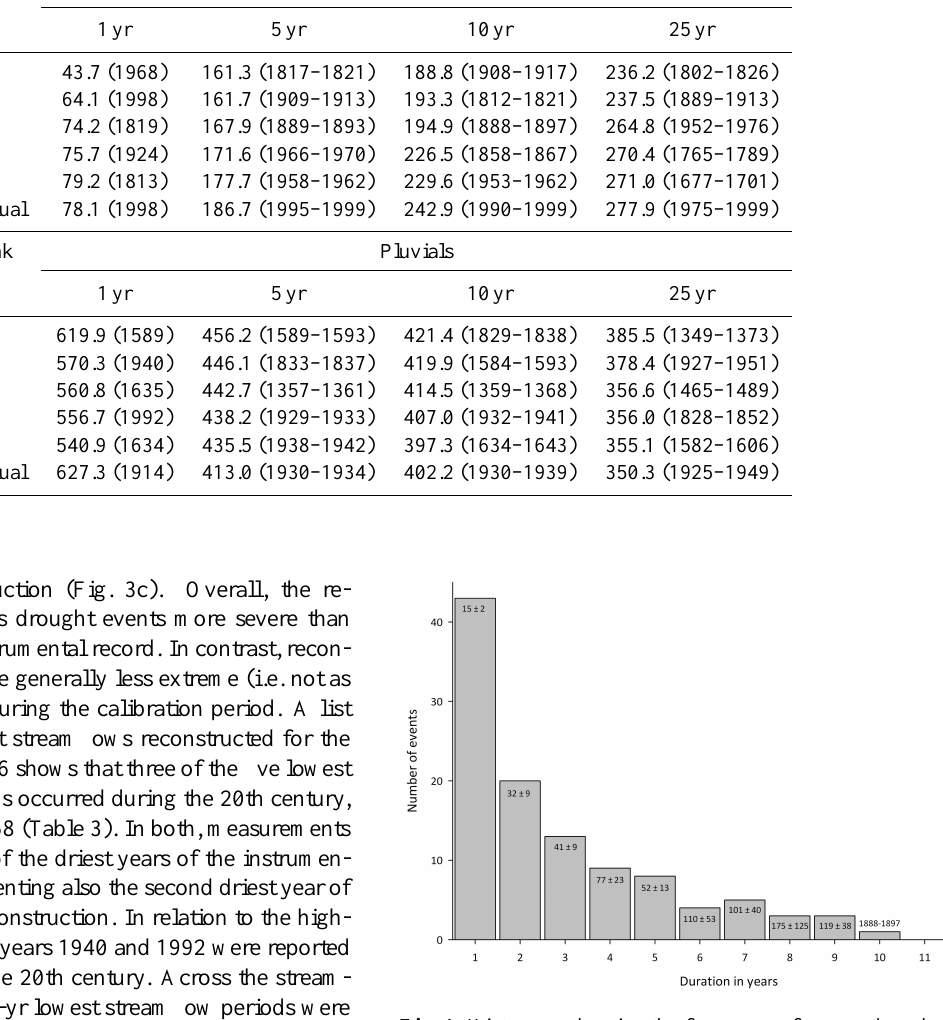
Fig. 4. Histogram showing the frequency of n -year drought events (one to 12 consecutive years below the long-term mean) for the 1346–2000AD Neuqu´en River streamflow reconstruction. The long-term mean (1346–2000) was used for comparisons, because the values are normally distributed (Shapiro Wilk test W =0.999, p =0.861). Numbers inside the bars indicate the mean drought in- terval plus or minus one standard error